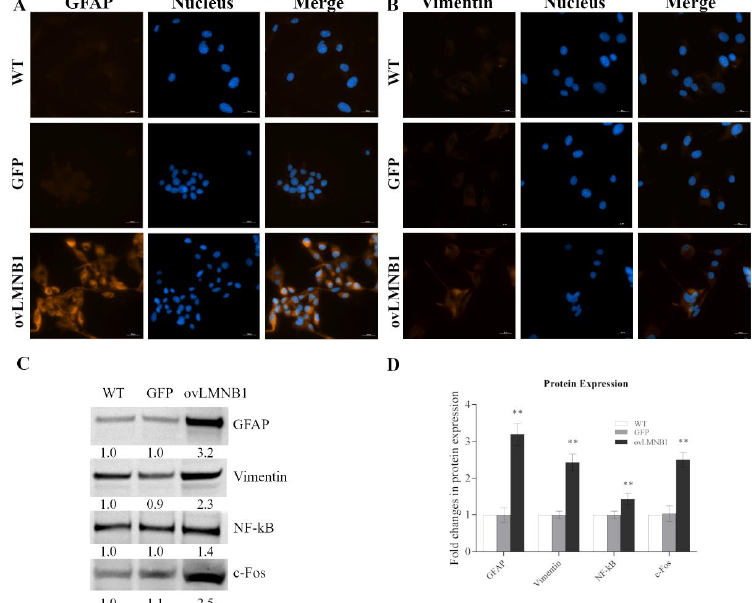
Figure 5. Lamin B1 accumulation induces the expression of markers of reactive astrocytes: The expression levels of reactive astrocytes markers were evaluated in U87-MG astrocyte-like cells transduced with Lamin B1-coding vector (ovLMNB1) and compared to wild type (WT) and mock-transduced cells (GFP). ( A , B ) display immunofluorescence staining of GFAP and vimentin, respectively, at 40× magnification (bar: 20 µM). Nuclei were stained using Hoechst 33342 (blue). Results are representative of at least five different fields. ( A , B ): In WT and GFP samples, only background fluorescence is seen for GFAP and vimentin, while the signal is strong in ovLMNB1 samples. ( C ): GFAP, vimentin, nuclear NF-kB, and c-Fos expression was measured in wild type, mock-transduced (GFP), and Lamin B1-overexpressing cells. Samples were normalized by using total protein normalization vs. wild type cells. Results are representative of three independent experiments. ( D ): Quantitative analysis of protein expression; wild type cells (WT) were used as reference sample. ** denotes p < 0.01 vs. corresponding mock- transduced sample (GFP).